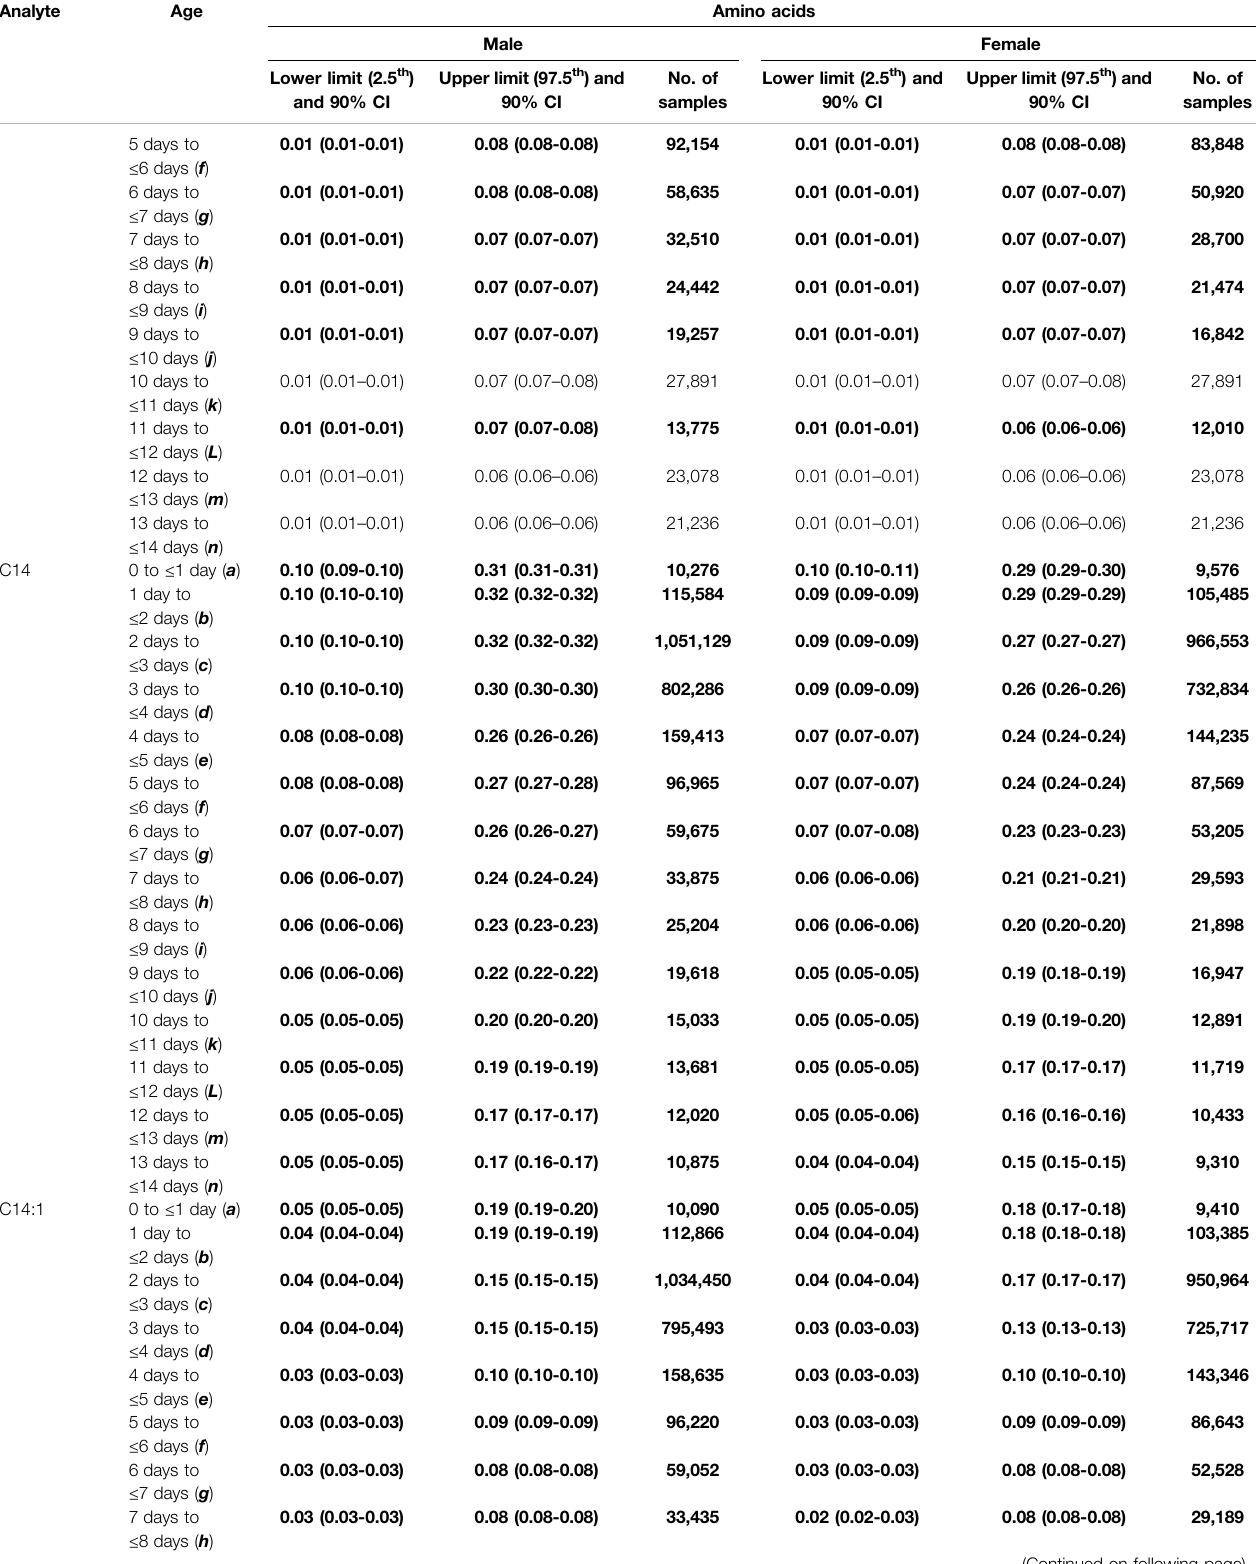
TABLE 2 | ( Continued ) The Reference intervals partitioned by each day and sex for 35 MS/MS NBS biomarkers ( μ